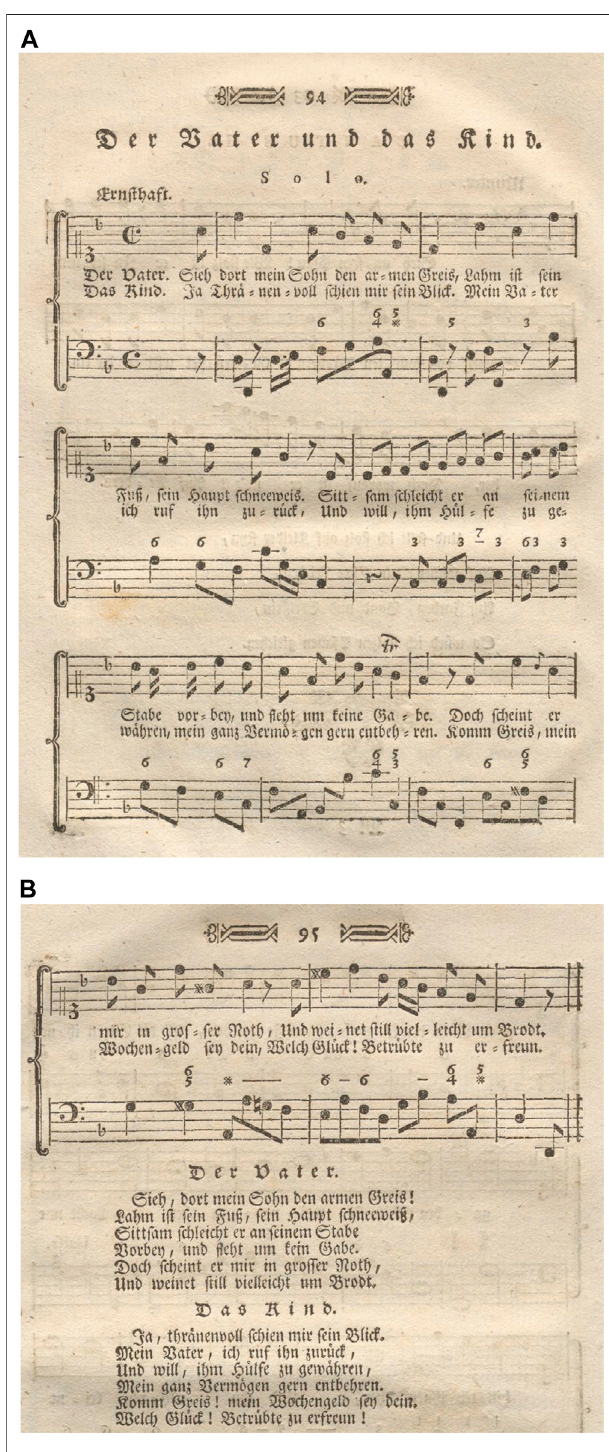
FIGURE 6 | Burmann, “ Der Vater und das Kind ” (text: Patzke), from G. W. Burmanns Kleine Lieder für kleine Mädchen und Knaben (1774, 94 – 95). Courtesy of Zentralbibliothek Zürich, shelfmark